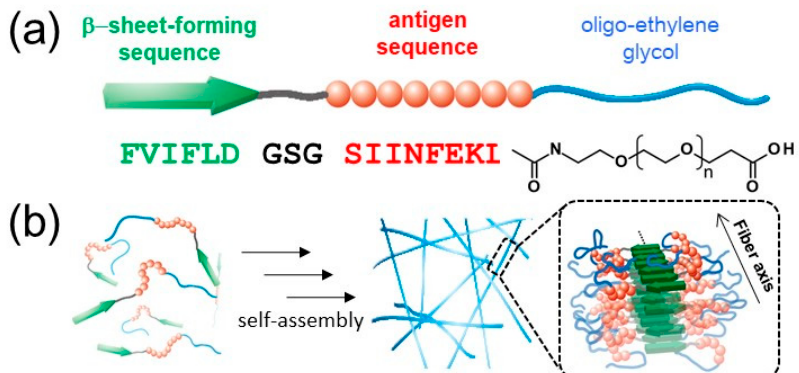
Figure 1. ( a ) Design of the building block peptides (EG n ) that are composed of a β -sheet-forming sequence (FVIFLD), a flexible-linker block (GSG), a model antigen sequence (SIINFEKL from OVA), and oligo-ethylene glycol. ( b ) Schematic illustration of the self-assembly process for nanofiber formation and the proposed model of highly antigen-loaded nanofibers based on previous structural study [36]. The schematic illustration was created by modification of Figures 1 and 2 of reference [35].